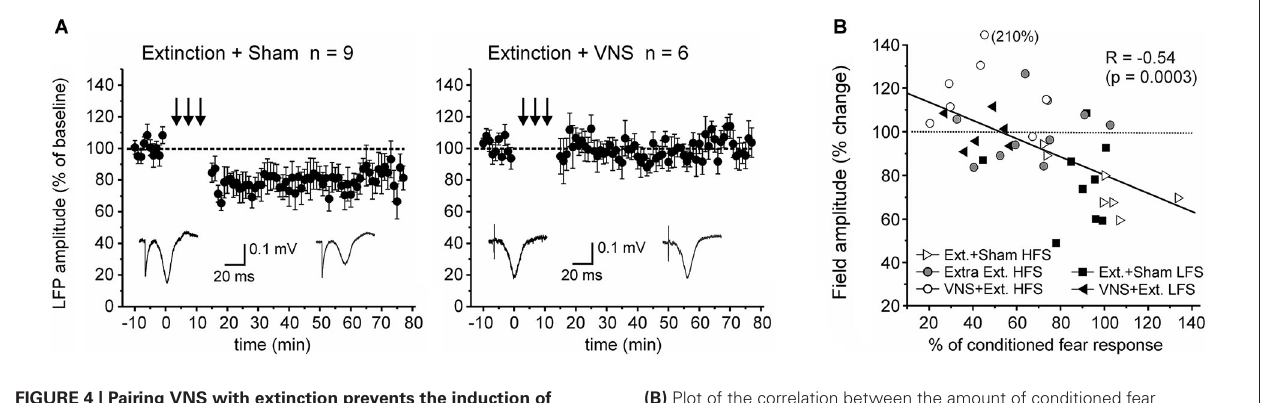
(B) Plot of the correlation between the amount of conditioned fear response on day 6 and the change in EFP amplitude following high-frequency (HFS, c.f. Figure 2 ) or low-frequency stimulation